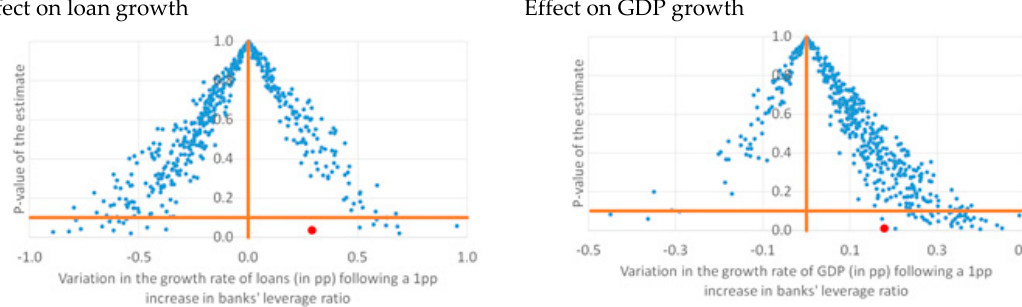
Figure A2. Estimates of the effect of bank capital on loan growth and GDP growth.